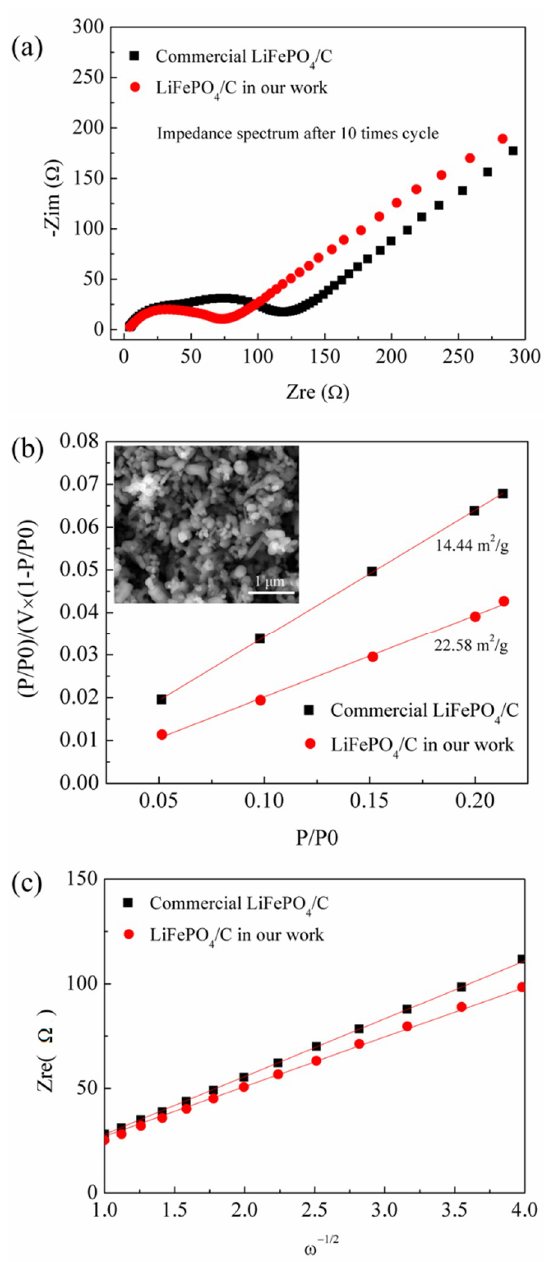
Figure 6. ( a ) The electrochemical impedance spectra (EIS); ( b ) variations and fittings between Z Re and ω − 1/2 (the reciprocal square root of the angular frequency ω ) in the low-frequency region; and ( c ) specific surface area test (insert is the SEM image of commercial LiFePO 4 /C) of our LiFePO4/C composite in comparison with those of the commercial LiFePO 4 /C composite.